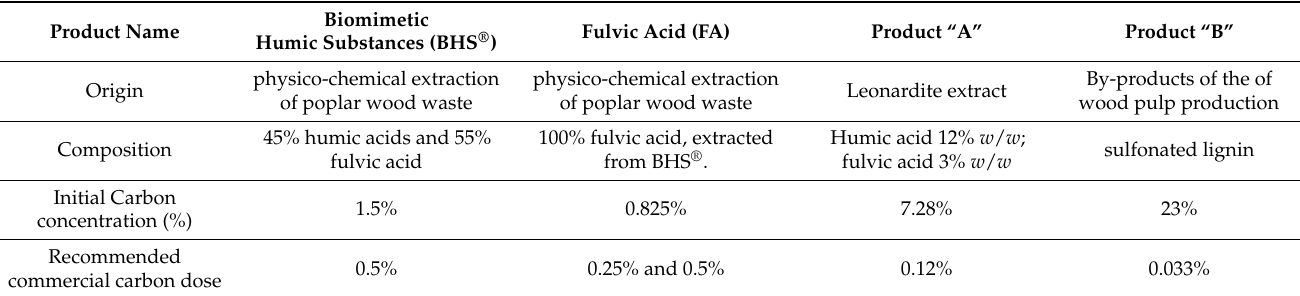
Table 1. Characteristics of the commercial products